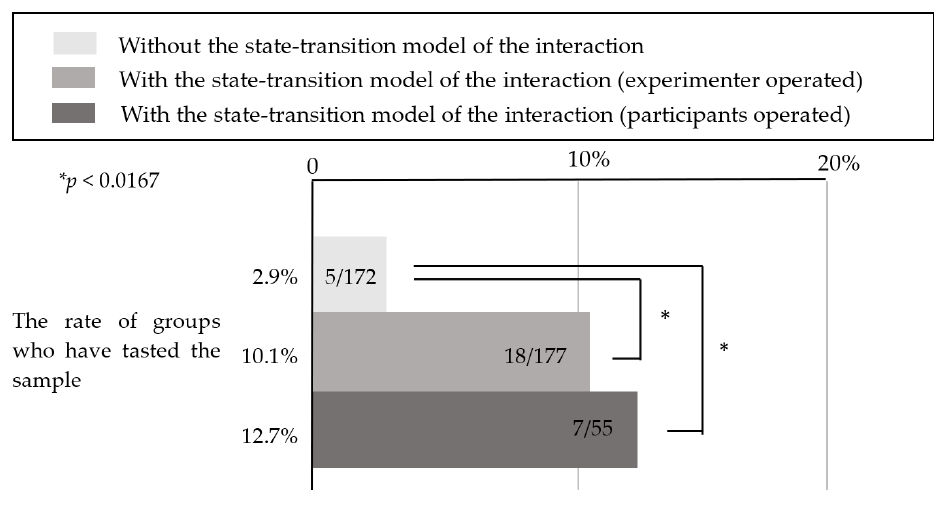
Figure 22. Ratio of customers who tasted a sample under each condition.